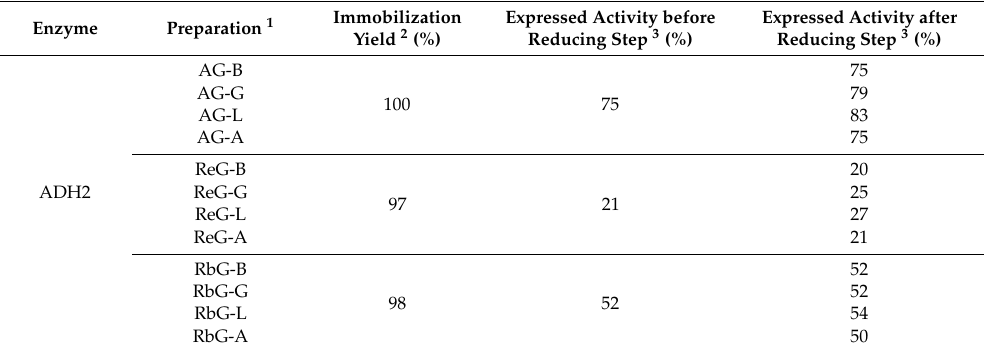
Table 3. Immobilization summary of the ADH2 on the di ff erent supports and blocking agents.